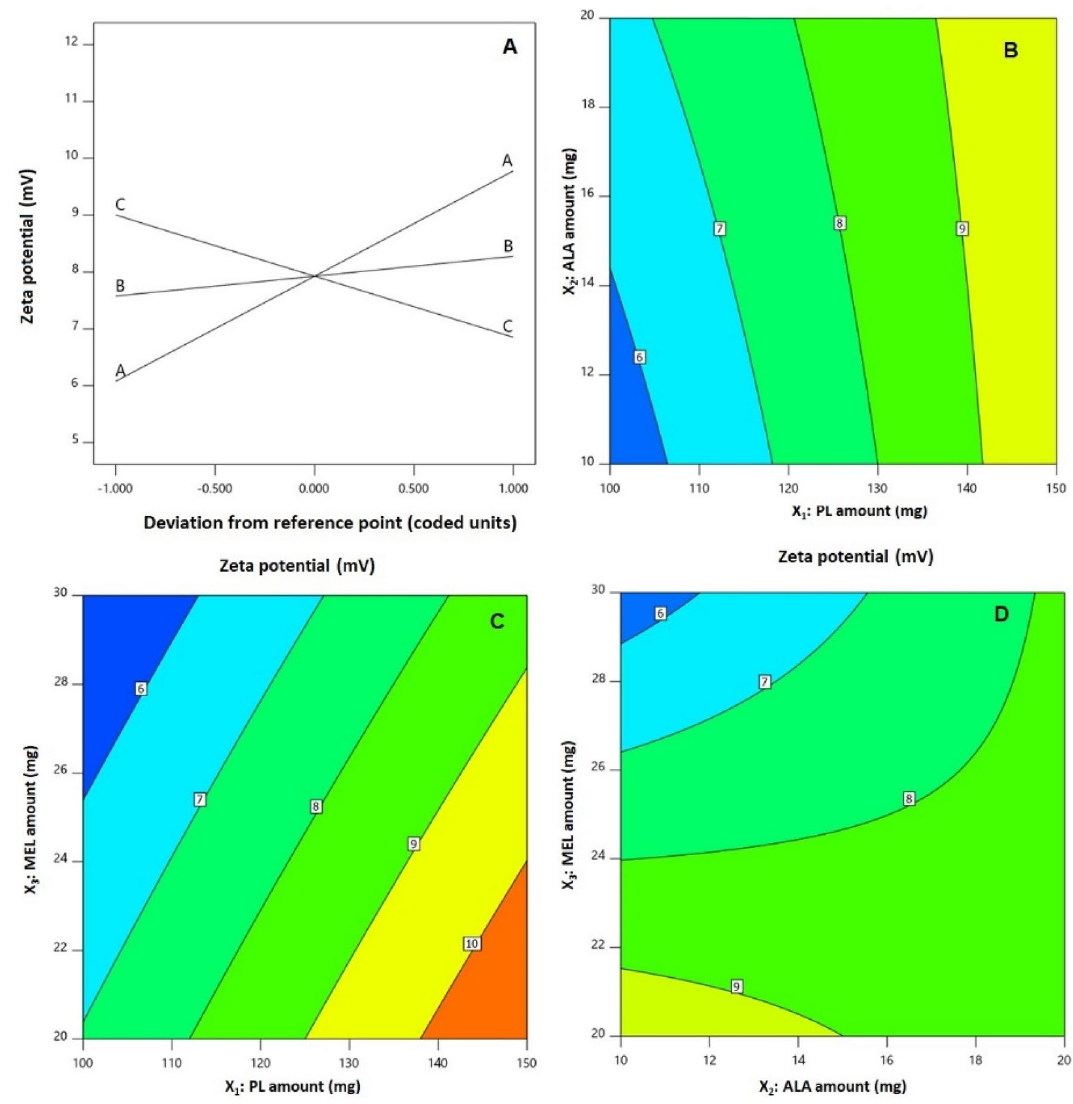
Figure 4. Perturbation plot ( A ) and Contour 2D-plots ( B – D ) showing the effect and interaction between investigated variables on the zeta potential of FLV-PL-ALA-MEL nanoparticles.